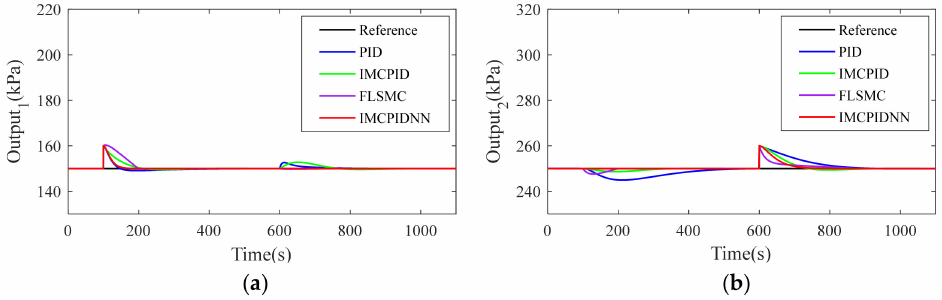
Figure 12. Comparison of closed-loop responses to external disturbance with matching model: